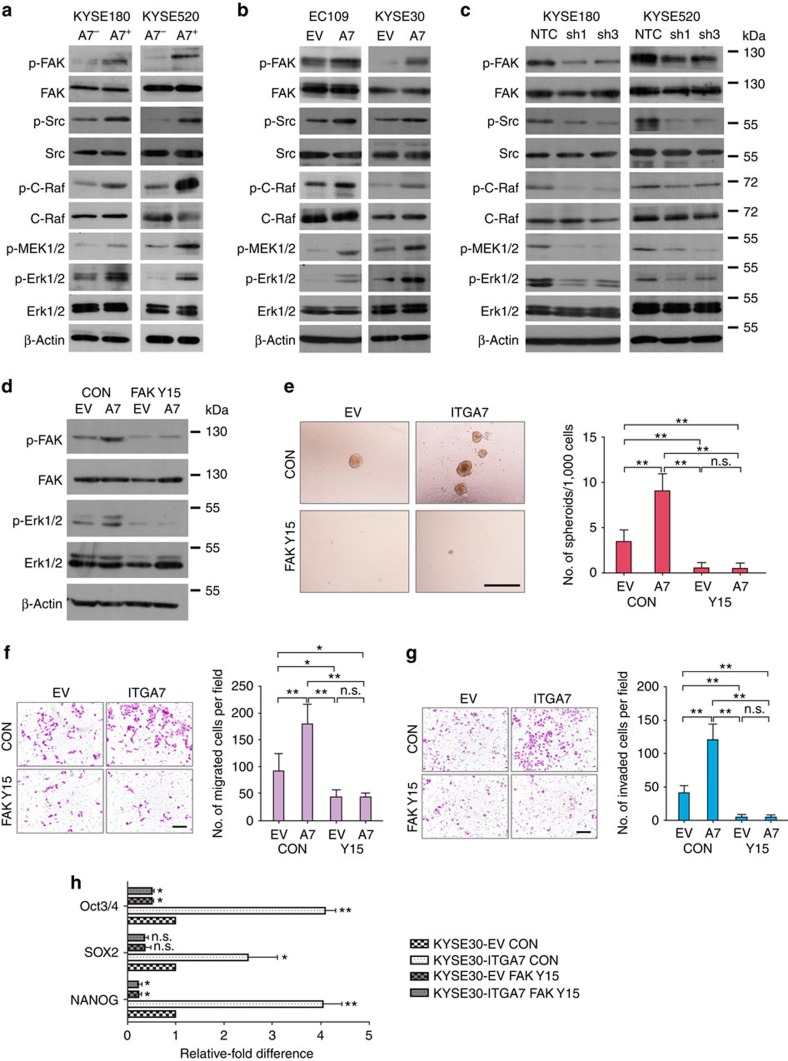
ITGA7 drives cancer stemness features in OSCC via the FAK/MAPK/ERK signalling.(a–c) Western blot analyses showed that the FAK/MAPK/ERK pathway was activated in sorted ITGA7+ cells and ITGA7-transfected cells, while inhibited in ITGA7 silencing cells. β-Actin was used as a loading control. (d) Western blot analyses showed that the phosphorylation of FAK and downstream player Erk1/2 was significantly blocked in ITGA7-transfected KYSE30 cells after treatment with 7.5 μM FAK inhibitor Y15. Functional assays demonstrated that Y15 treatment could effectively inhibit spheroid formation ability (e; 500 μm scale bar), cell migration ability (f; 200 μm scale bar), cell invasion ability (g; 200 μm scale bar) and the expression of stemness-related genes in ITGA7-transfected cells (h). The number of spheroids and migrated or invaded cells was calculated from three independent experiments and depicted as the mean±s.d. in the bar chart. Statistics: (e–h) ANOVA with post hoc test. *P<0.05; **P<0.001; n.s., P≥0.05.